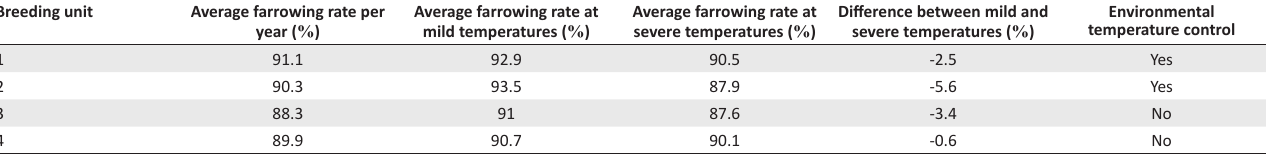
TABLE 2: Farrowing rates ( % ) for different breeding units associated with temperature control. Breeding unit Average farrowing rate per